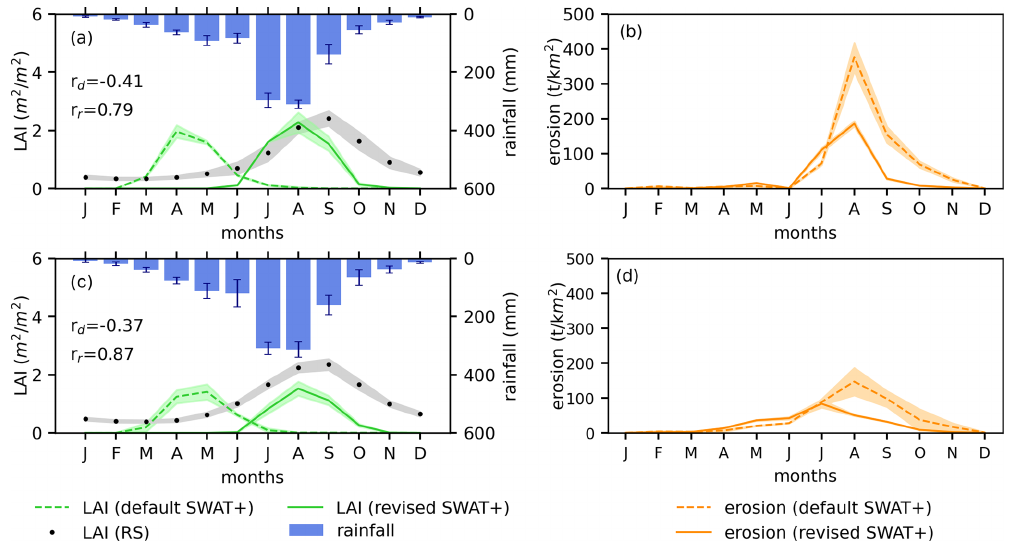
Figure A1. Monthly mean and standard deviation (bands) of (a, c) LAI and (b, d) erosion comparison for rainfed wheat and for irrigated wheat, respectively, in the Upper Blue Nile basin. The LAI correlation coefficients ( r d for the default SWAT + model and r r for the revised SWAT + model) are shown.